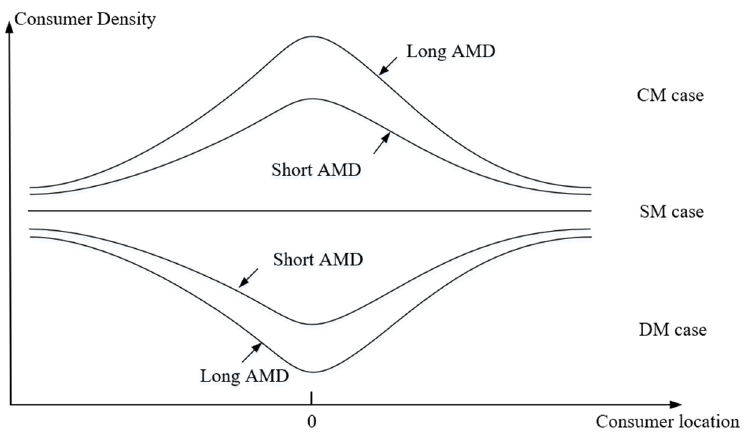
Figure 2. Consumer distribution with respect to OMT.